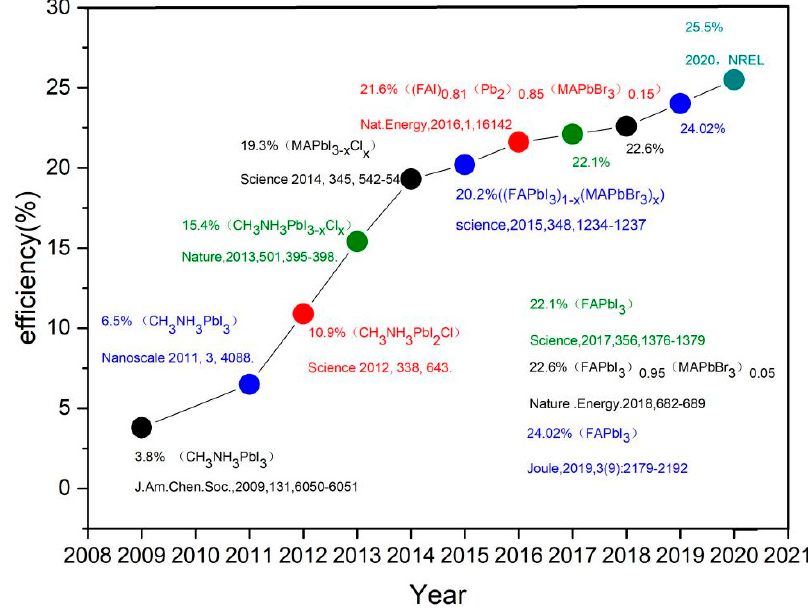
Figure 2. The evolution of the efficiency of perovskite solar cells (PSCs) from 2008 to 2020.